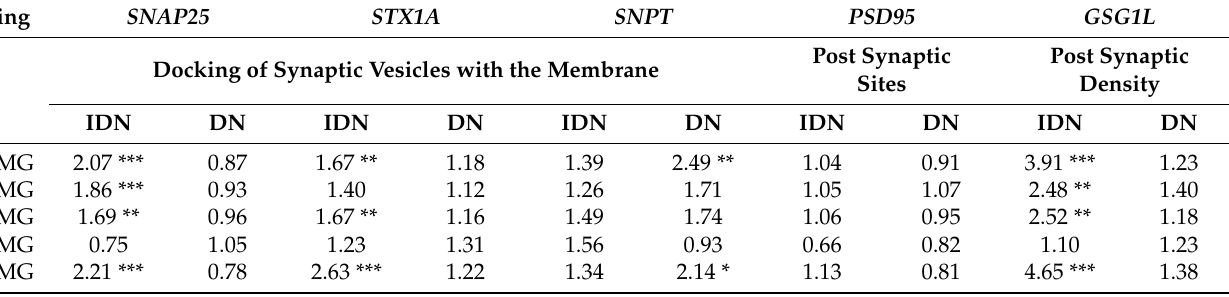
Table 3. Relationship between the expression levels of the synapse-specific genes in human IDNs and DNs cultivated on CCs compared with